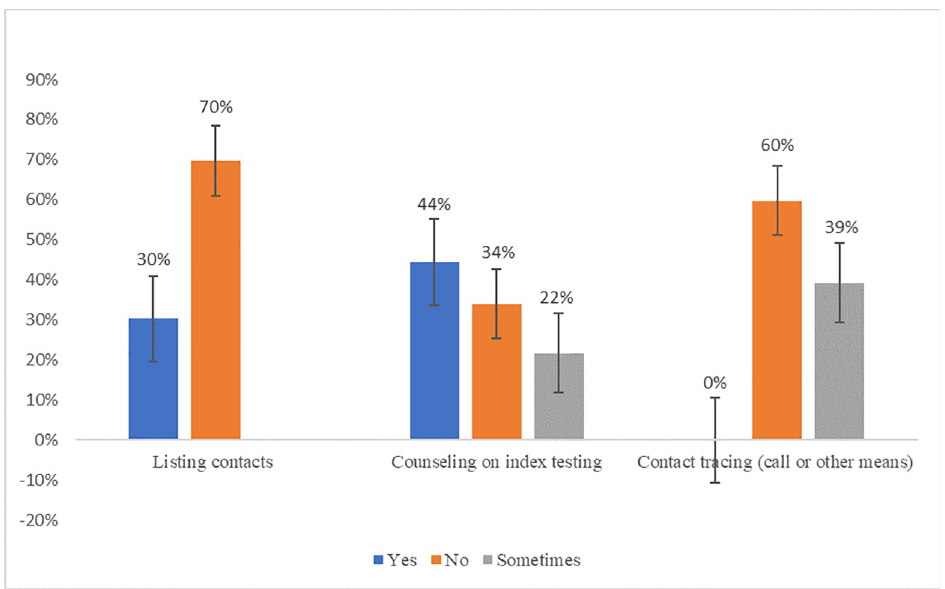
Fig 2. Clinical providers involvement in index testing. Responses on index clients counseling, listing contacts and tracing contacts.